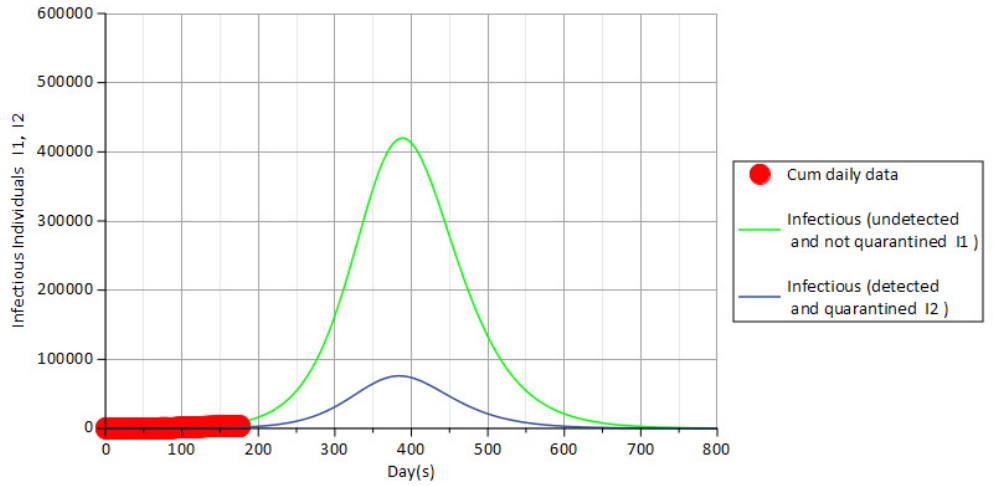
Figure 4. Cumulative daily infectious individuals (red), I 1 ( t ) (green) and I 2 ( t ) (blue) for face masks usage σ f = 0.05 with other parameters as in Table 3